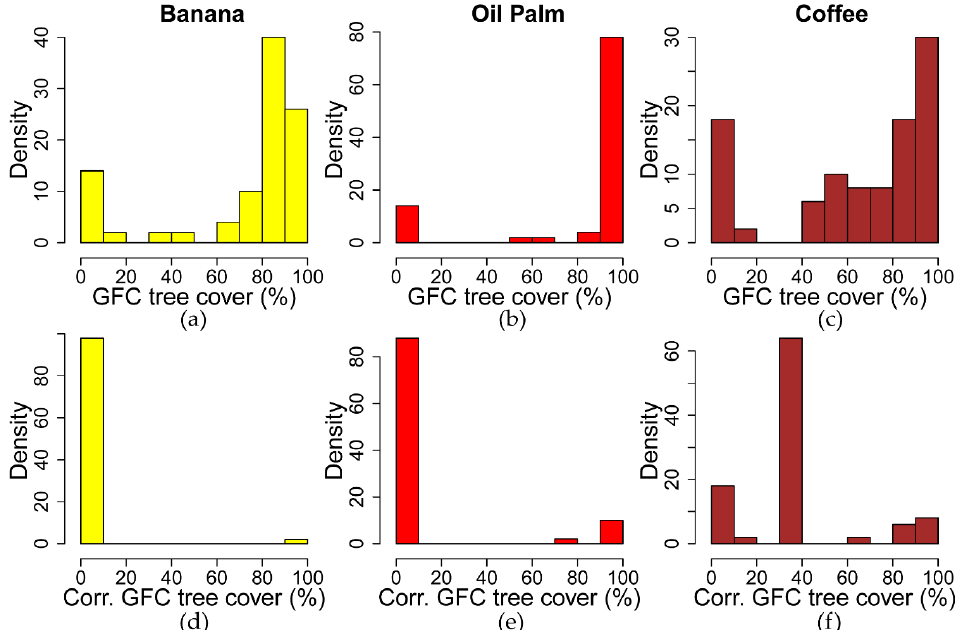
Figure 6. Panels ( a – f ) compare the distribution of tree cover in the GFC and revised forest maps for three agricultural species. These histograms show the estimated 2015 tree cover in banana, oil palm, and co ff ee fields, before and after tree cover was corrected using an agricultural land cover mask. Tree cover percentage is on the x-axis, and the percentage of agricultural training data points (n = 300) in each histogram bin is on the